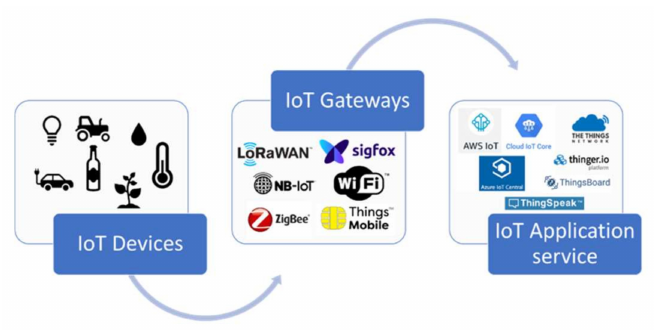
Figure 2. Scheme of the levels of the Internet of Things (IoT)